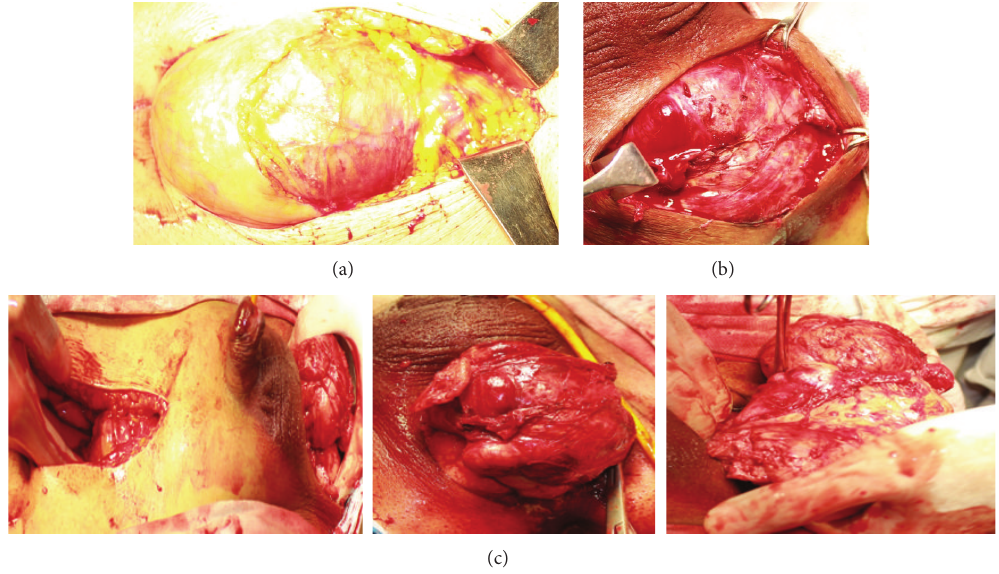
Figure 3: (a) Initial abdominal approach, (b) perineal approach, and (c) two approaches combined and final delivery of specimen from perineal incision.